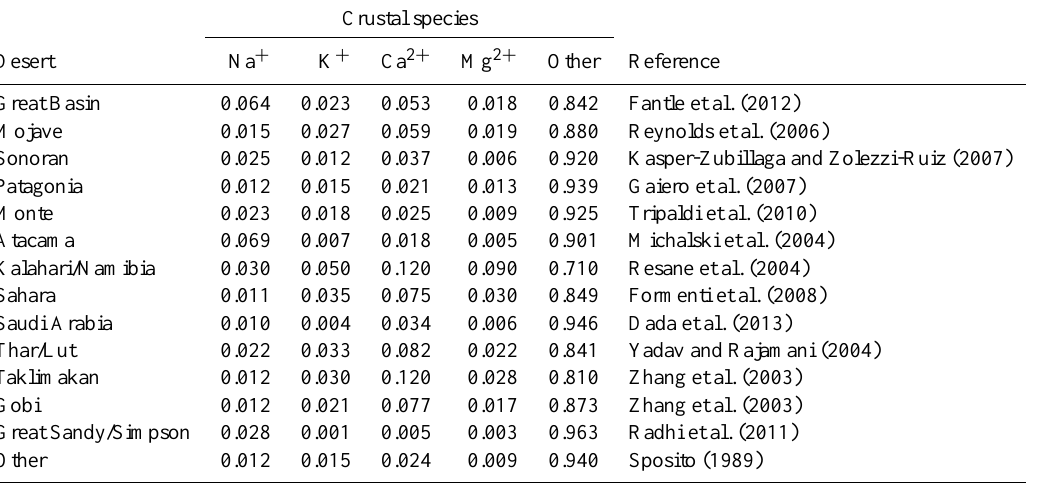
Table 1. Chemical composition of mineral dust.